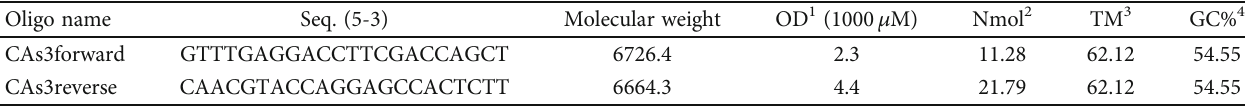
Table 1: Primers and probes of